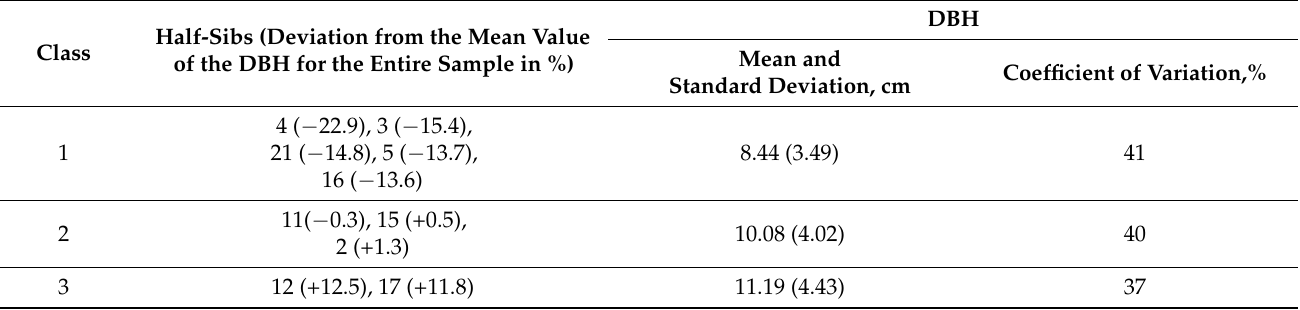
Table 2. Data clustering in the context of the provenance factor.